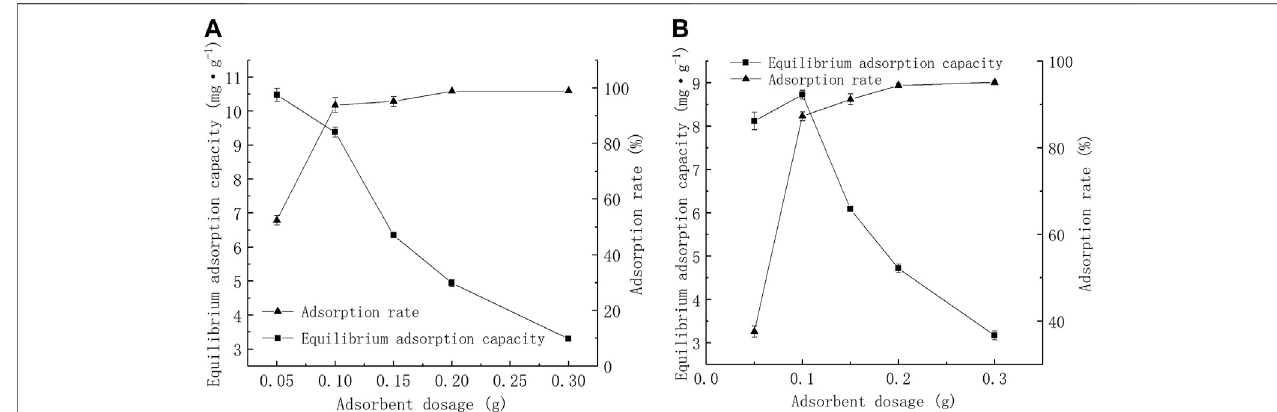
FIGURE 3 | Effect of dosage on Pb 2+